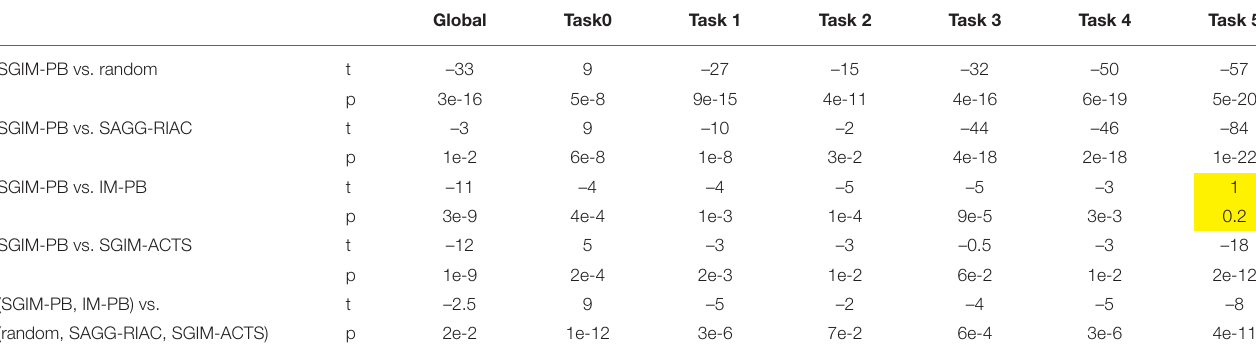
TABLE A1 | Student’s t -test on two samples for comparing SGIM-PB with each of the algorithms and for comparing the procedure algorithms (SGIM-PB and IM-PB) to algorithms without the procedure framework (SGIM-ACTS, SAGG-RIAC and random).